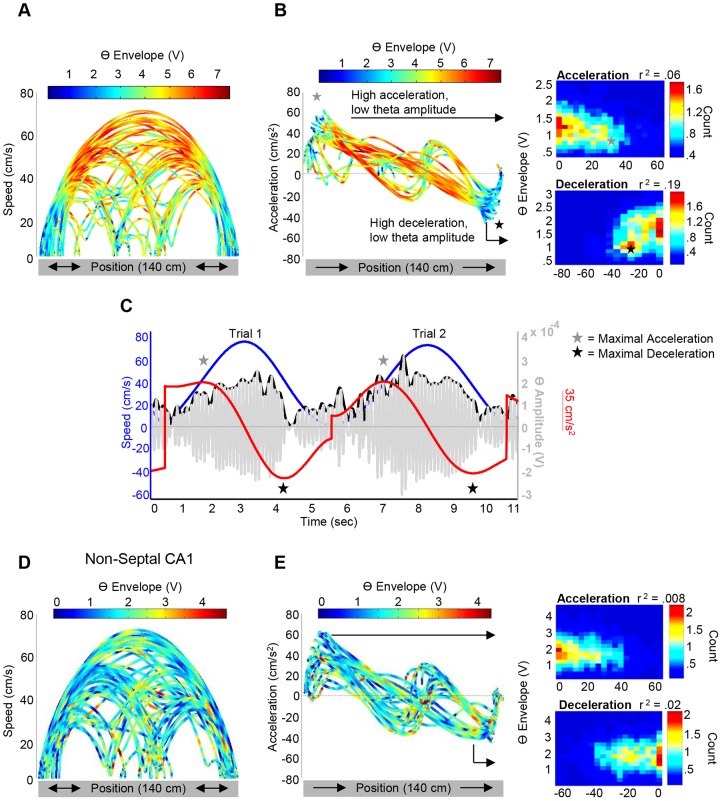
Speed, acceleration/deceleration and septal theta amplitude as a function of position on the maze.
A: Three-dimensional scatterplot rotated to a specific view showing the relationship between position on 140-cm maze (x-axis), speed (y-axis), and color-coded for theta amplitude. As can be seen, with increasing and maximal speeds (centered in the middle of the maze) theta amplitude increases. B (left): Same as A, but for acceleration in one direction (rat moving from left to right) as denoted by the black arrows on the x-axis. At high accelerations and high decelerations theta amplitude is low and increases in amplitude at less extreme accelerations. Gray star denotes high accelerations and low theta amplitude, while the black star denotes high decelerations and low theta amplitude. B (right): Two-dimensional histograms depicting the relationship between acceleration and theta amplitude (top) and deceleration and theta amplitude (bottom). C: Filtered theta signal (gray) and theta envelope (black) plotted along with speed (blue) and acceleration (red). As can be seen, there is a sharp reduction of the theta amplitude at extreme accelerations and decelerations, and is more pronounced at high decelerations, as represented by the three-dimensional scatter plot and two-dimensional histograms in B. Gray stars represent time points of maximal acceleration, while black stars represent points of maximal deceleration. D and E: Same as A and B, but for a non-septal electrode. (All theta envelope units = ×10−4; all count units = ×103).